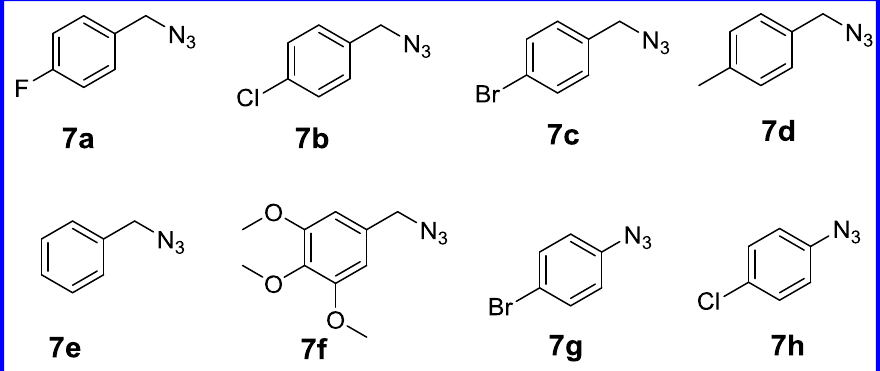
Figure 4. Azide derivatives 7a – 7h used in this study.